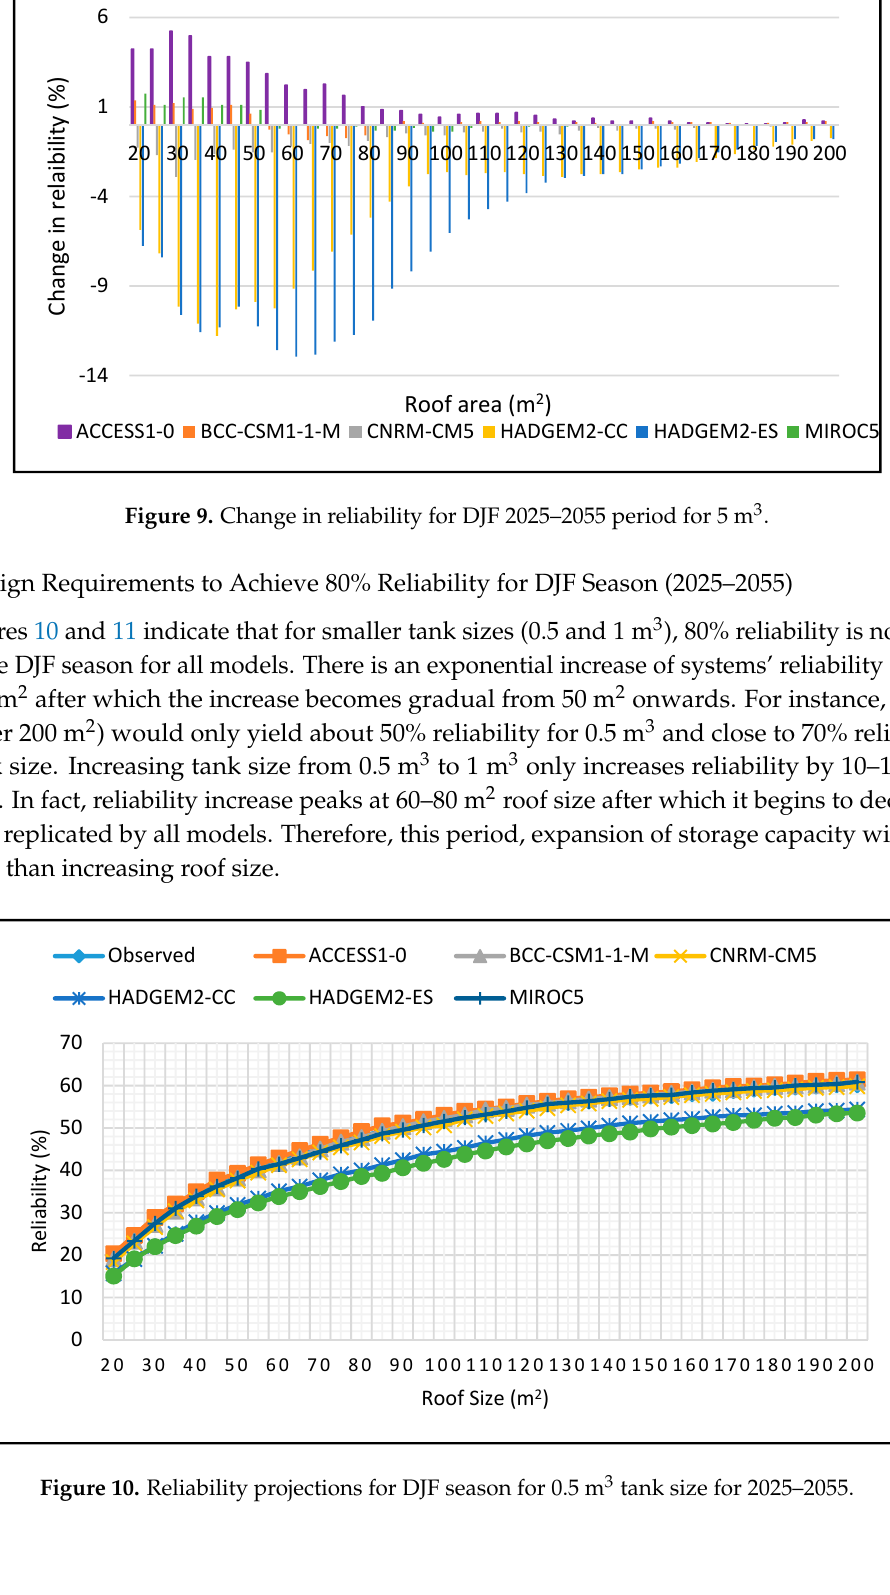
Figure 11. Reliability projections for DJF season for 1 m 3 tank size for 2025–2055. When the tank size is increased to 2 m 3 ,as shown in Figure 12, 80% reliability is achieved between 100 to 110 m 2 roof size for the observed scenario and by ACCESS1-0, BCC-CSM1-1-M, MIROC5 and CNRM-CM5 models. However, HADGEM2-CC predicts a roof size requirement of 160 m 2 and 180 m 2 for HADGEM2-ES as indicated in Figure 10. This is an increase of 60–80 m 2 from what is currently needed to maintain 80% reliability. Figure 13 shows that increasing the storage capacity to 5 m 3 reduces the roof size requirement for the attainment of 80% reliability to 50–60 m 2 for the observed and ACCESS1-0, BCC-CSM1-1-M, MIROC5 and CNRM-CM5 models. 80% reliability is achieved at 70 and 85 m 2 for HADGEM2-CC and HADGEM2-ES respectively. This is a 10–20 m 2 increase in roof size from observed requirement. Notably, reliability projections for all models and observed scenario converge when roof sizes are increased beyond 80 m 2 with tank volumes of 5 m 3